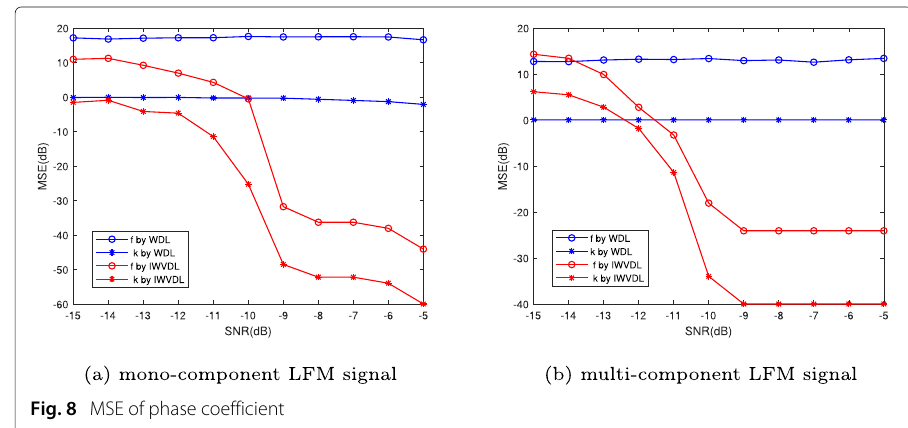
Fig. 8 MSE of phase